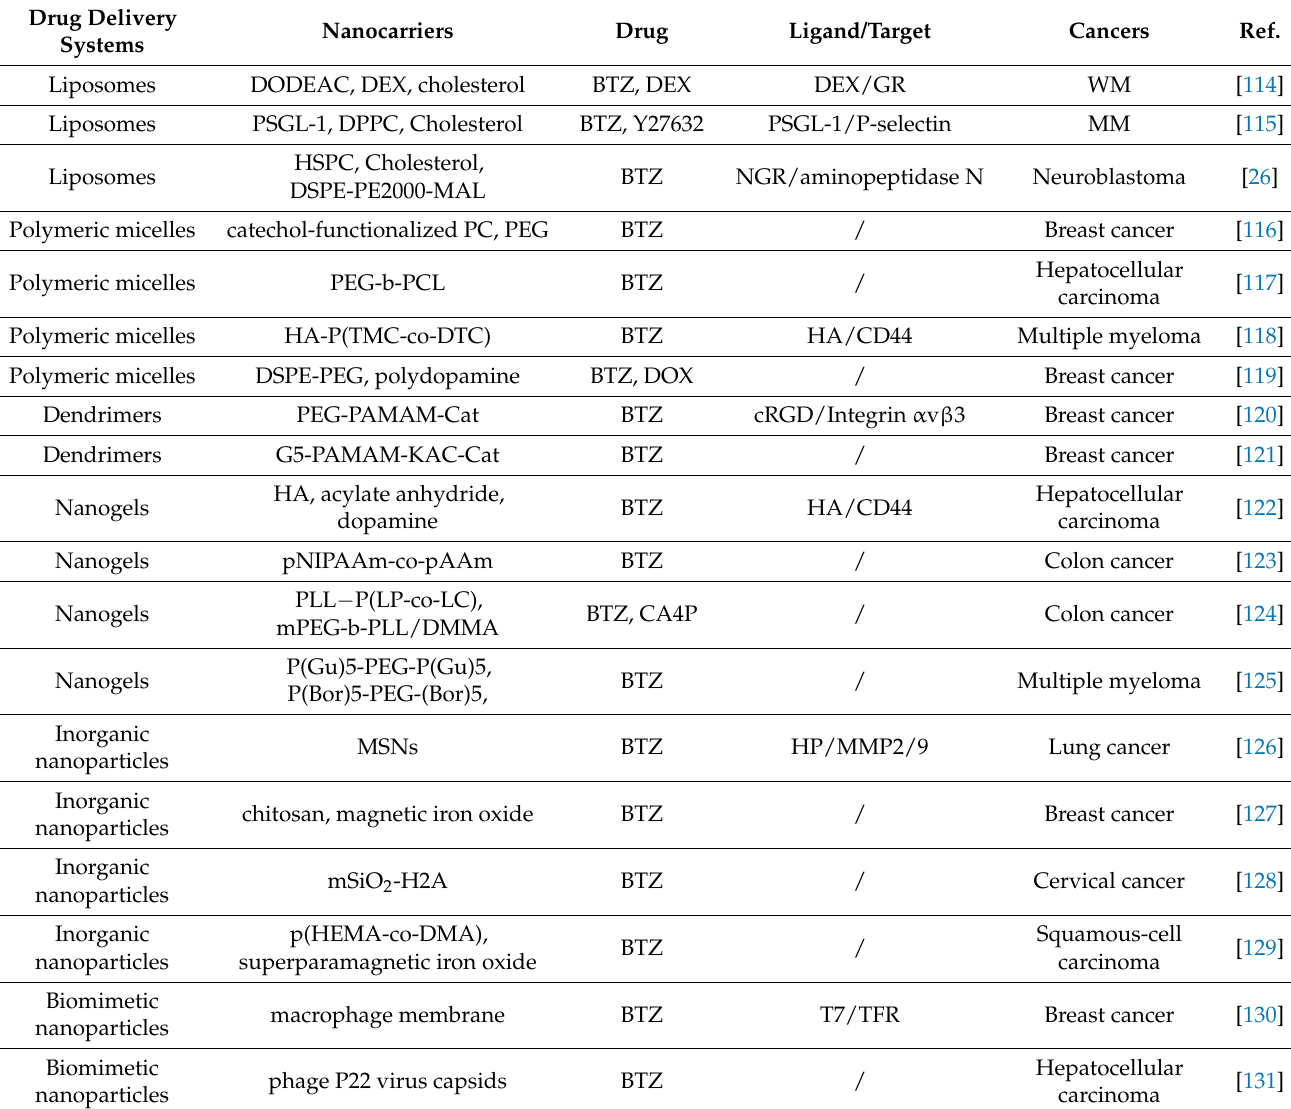
Table 3. Representative BTZ-based nanoformulations in cancer